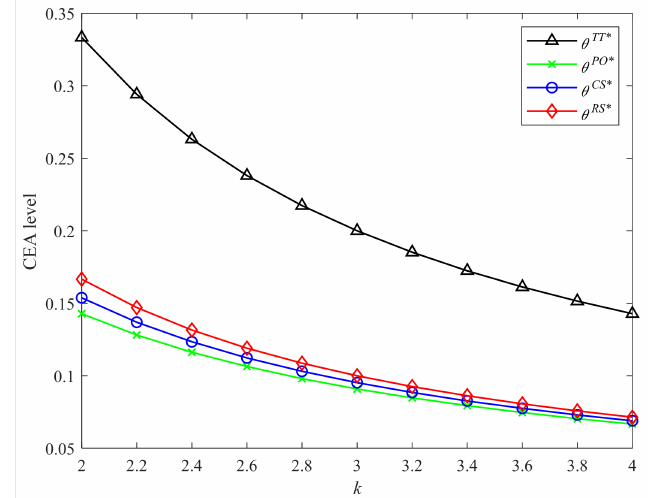
Figure 3. Comparison of CEA levels with different k